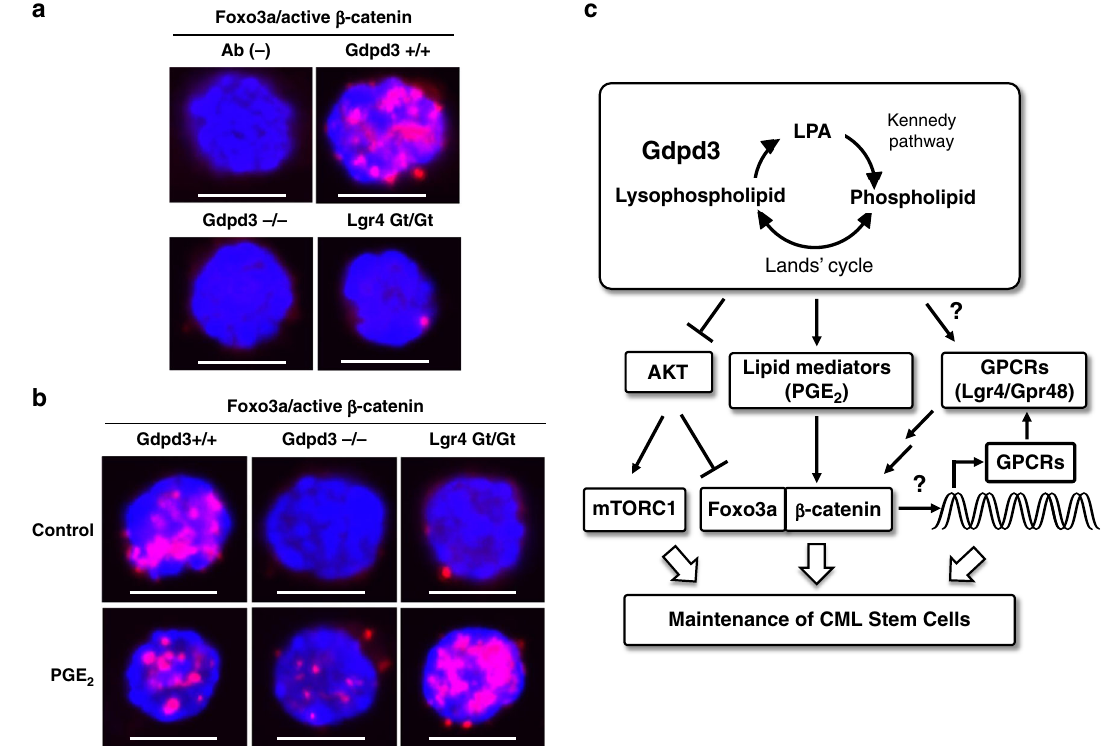
Fig. 8 Gdpd3 and lysophospholipid metabolism are required for the maintenance of CML stem cells in vivo. a , b Duolink ® in situ PLA imaging to detect interaction between Foxo3a and active β -catenin in a freshly isolated LT-CML stem cells from Gdpd3 + / + tet-CML-affected mice (four males, two females), Gdpd3 − / − tet-CML-affected mice (three males, two females), or Lgr4 Gt/Gt tet-CML-affected mice (four females), at 5 weeks post-Dox withdrawal, and in b LT-CML stem cells that were isolated from Gdpd3 + / + tet-CML-affected mice (two females), Gdpd3 − / − tet-CML-affected mice (two females), or Lgr4 Gt/ μ M) for 2 h. Results are Gt tet-CML-affected mice (two females), at 5 weeks post-Dox withdrawal and treated in vitro with/without PGE 2 (10 representative of three biologically independent trials. Ab (-), technical negative control without primary antibody. Nuclei were visualised using DAPI. Scale bar, 10 μ m. c Diagram outlining the proposed role of lysophospholipase D Gdpd3 in CML stem cells. Gdpd3 hydrolyses lysophospholipids to generate LPAs. Gdpd3 de fi ciency in CML-affected mice results in decreased levels of certain LPAs and lipid mediators. Multiple downstream mechanisms, including (1) suppression of the AKT/mTORC1 pathway, (2) reduction of interaction between Foxo3a and β -catenin, and (3) altered expression of GPCR mRNAs such as Lgr4/Gpr48, may be involved in CML stem cell maintenance. Loss of Gdpd3 is suf fi cient to decrease CML stem cell numbers in vivo, indicating that Gpdp3 plays a key role in maintaining the self-renewal capacity of CML stem cells in an oncogene-independent manner. Thus, Gdpd3-mediated lysophospholipid metabolism appears to be essential for supporting CML